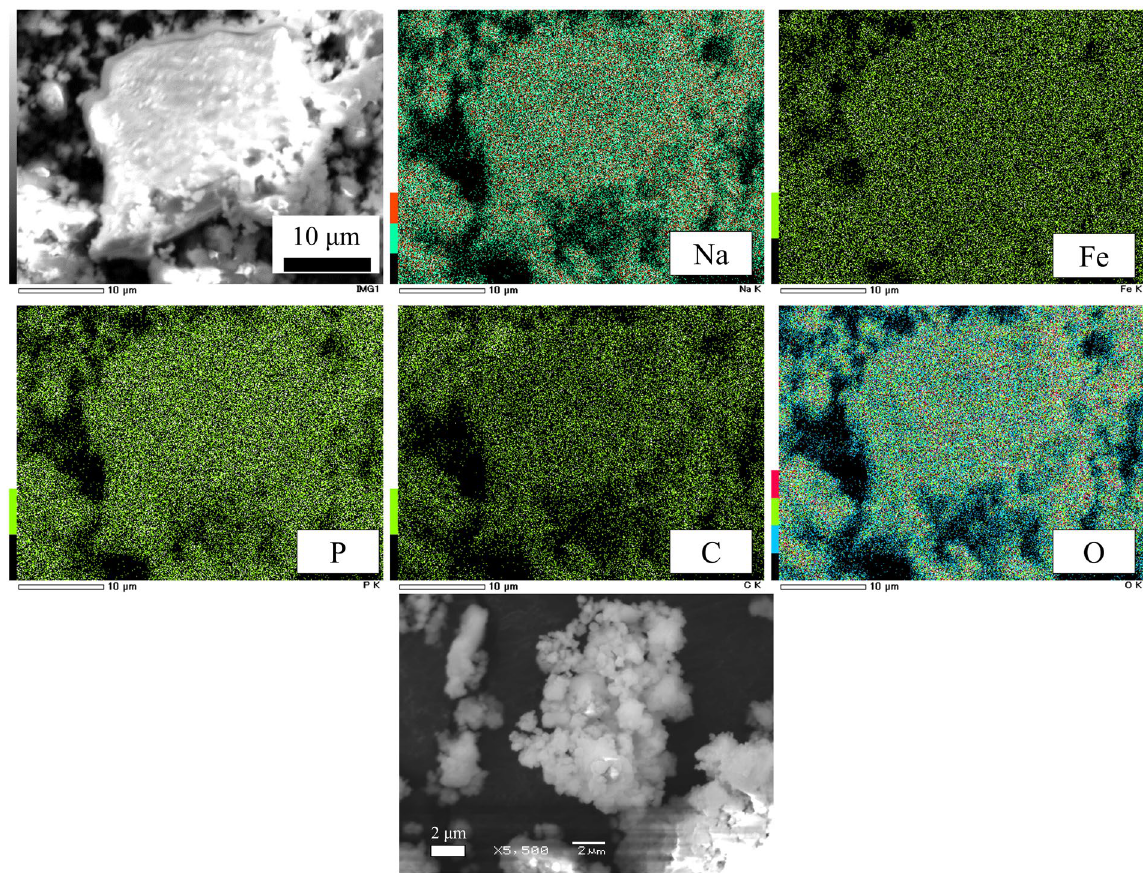
Figure 4. EDX mapping and SEM images of the